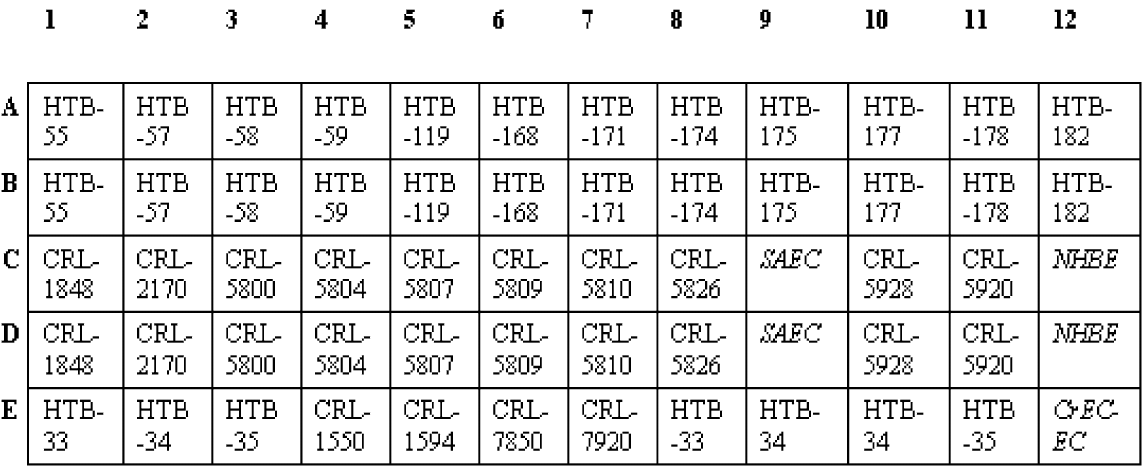
Fig. 1. The arrangement of 32 cell lines deposited onto a glass slide: The types in Italics have been purchased from Cambrex, whereas the rest have been purchased from ATCC. and liquid based cervical cytology specimens. BAL